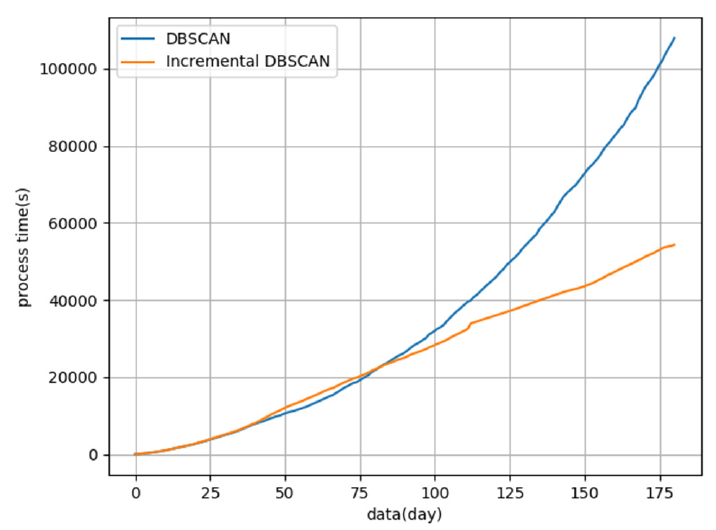
Figure 16. Comparison of clustering time between DBSCAN and incremental DBSCAN.